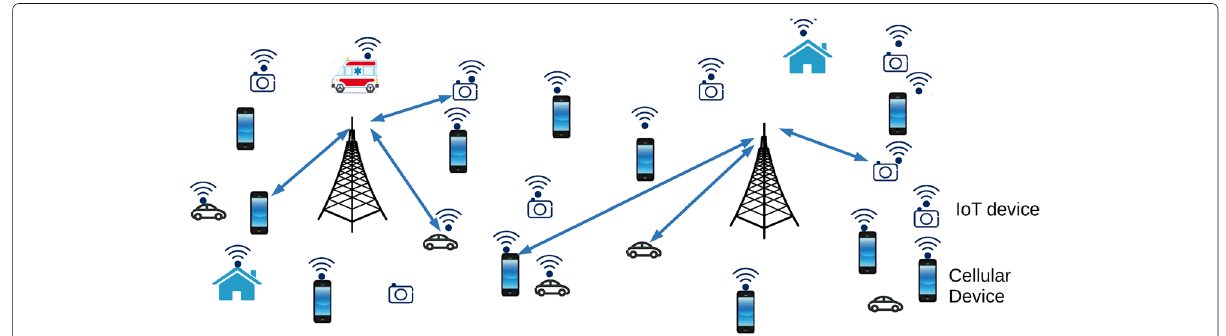
Fig. 1 Network scenario of future wireless